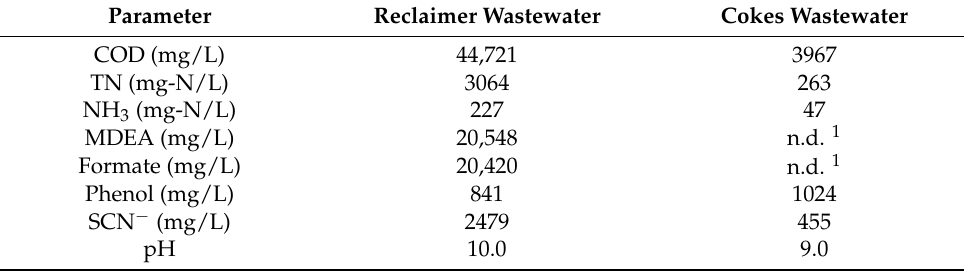
Table 1. Characteristics of